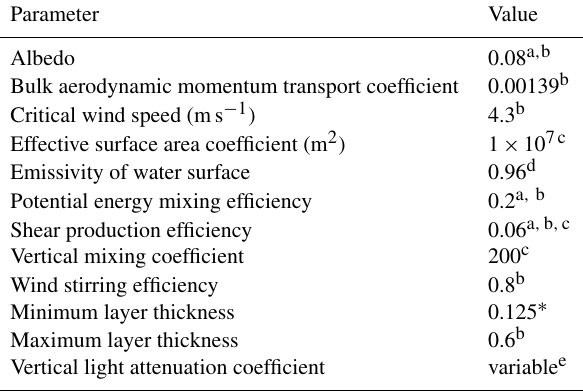
Table 2. DYRESM-WQ-I model parameters. Ice cover parameter can reference Magee et al. (2016) and Magee and Wu